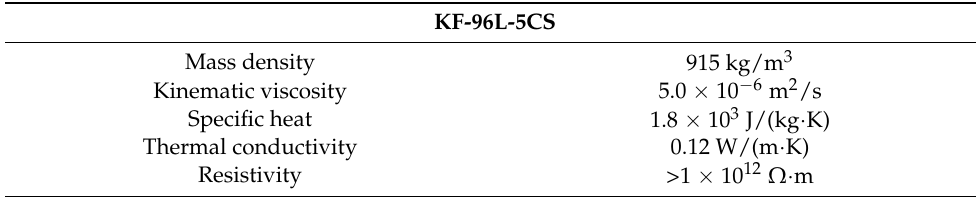
Table 1. Properties of silicone oil.